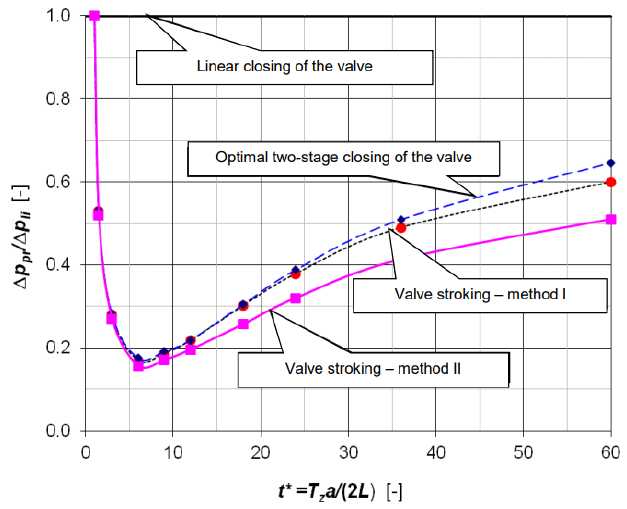
Figure 13. Comparison of efficacy in reducing the maximum pressure for different methods of controlling a turbine shut-off valve closing by different laws [103].